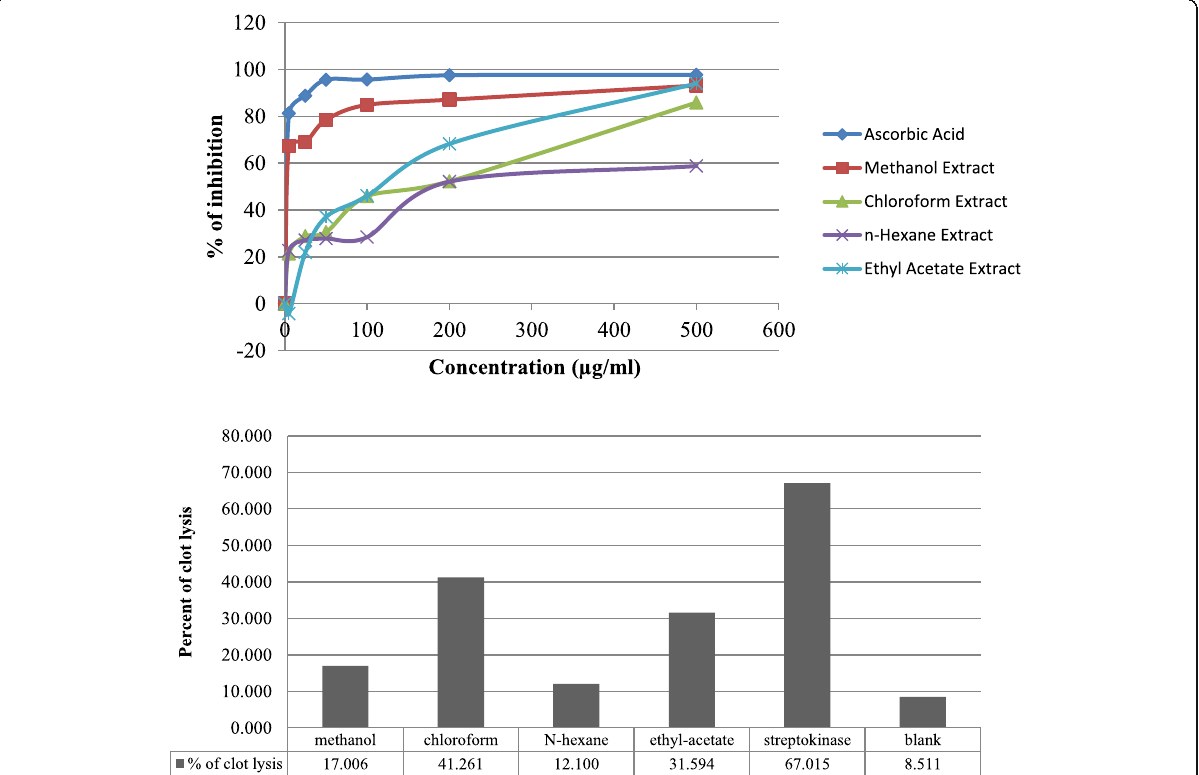
Fig. 1 Comparative percent of inhibition of DPPH free radicals and thrombolytic activity of different extracts of Cheilanthes